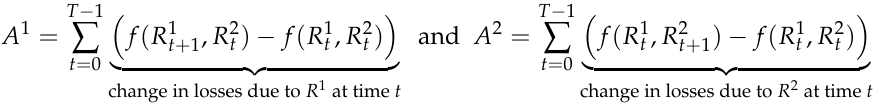
Figure 1. Computing the linear contributions f ( R 1 can lead to a large estimation